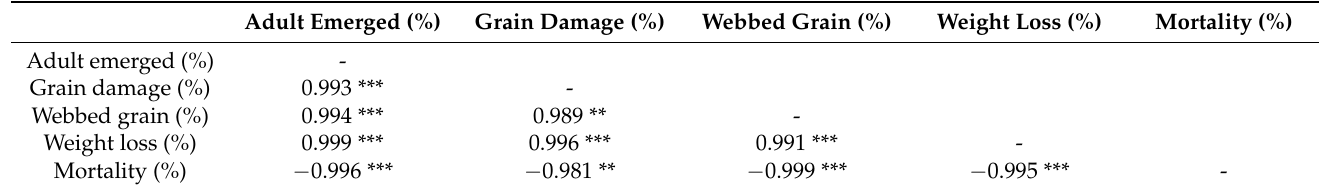
Table 1. Correlation coefficients between the measured secondary parameters and mortality of